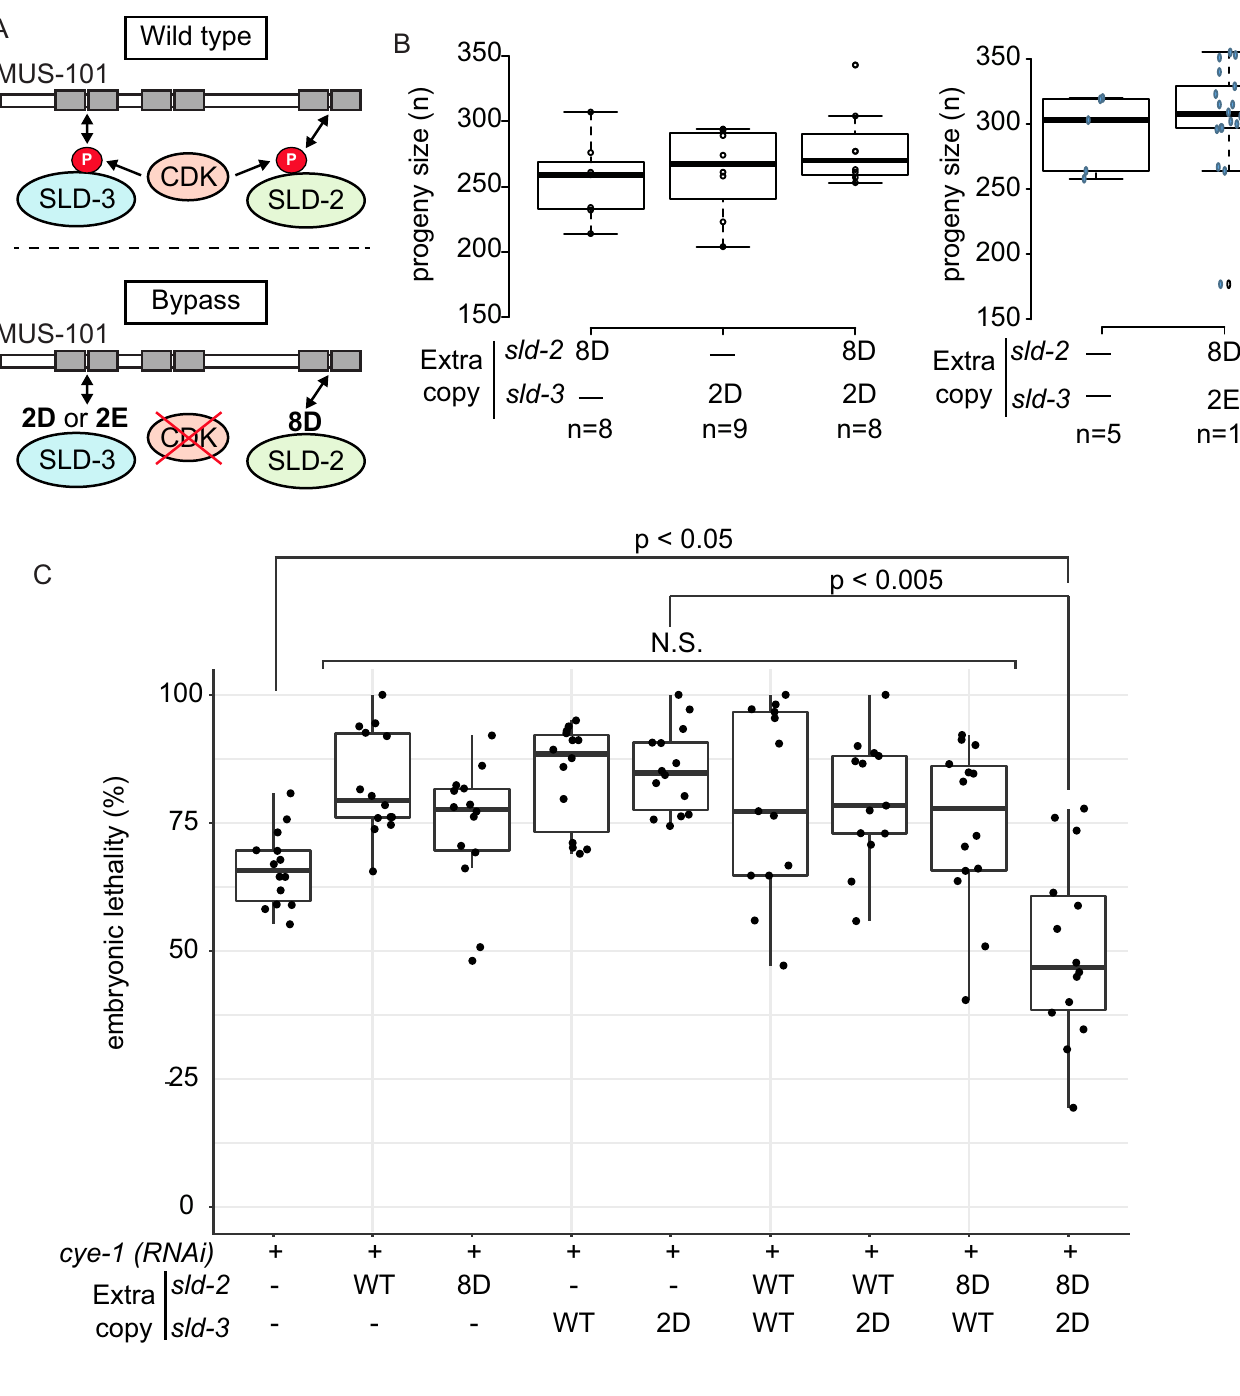
Fig 3. Bypass of CDK site phosphorylation in SLD-3 and SLD-2 is partially sufficient for cyclin E function A. CDK drives the interactions between SLD-2, SLD-3 and MUS-101 (top). The requirement for CDK can be bypassed using phospho-mimicking mutants in the essential CDK sites of SLD-2 (8D) or SLD-3 (2D or 2E). B. Box plot of progeny size for the indicated strains containing sld-2 and/or sld-3 mutants as extra copies as MosSCI insertions. n refers to the number of mothers analysed. C . Box plot of embryo lethality as in Fig 1C after cye-1 RNAi by feeding in the indicated strains. N.S = non-significant. n = 14 mothers for each condition. P values were calculated using a Mann whitney-Wilcoxon